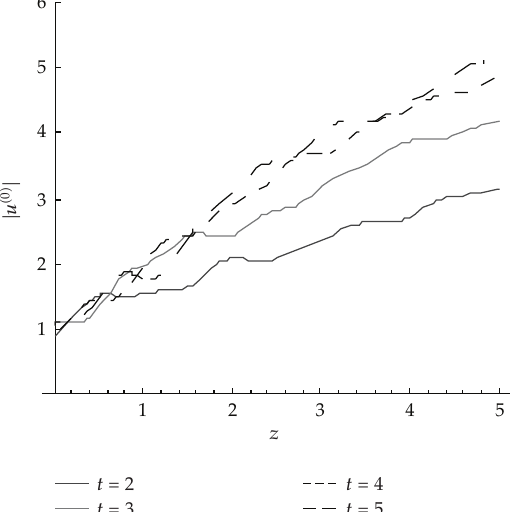
Figure 21: The zero-order approximation | u (cid:3) 0 (cid:4) | at α (cid:8) 1, T (cid:8) 10, γ (cid:8) 02 for di ff erent values of t , considering only one term in the series (cid:3) M (cid:8) 1 (cid:4) .